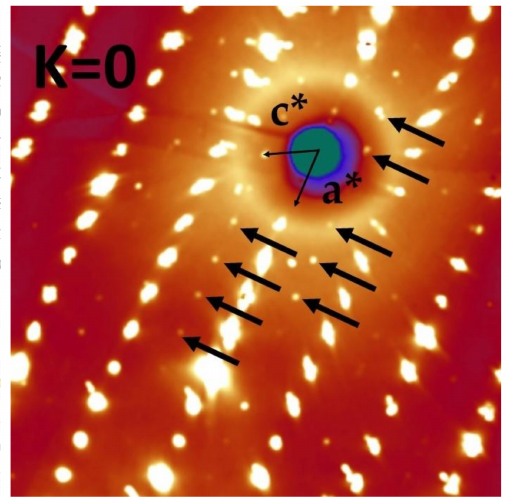
Figure 1. (Color online). Reconstruction of the ( a* , c* ) reciprocal plane taking into account the absorption correction. The thin arrows indicate the directions of the reciprocal lattice parameters, and the thick arrows show the reflections forbidden in the P2 1 /c space